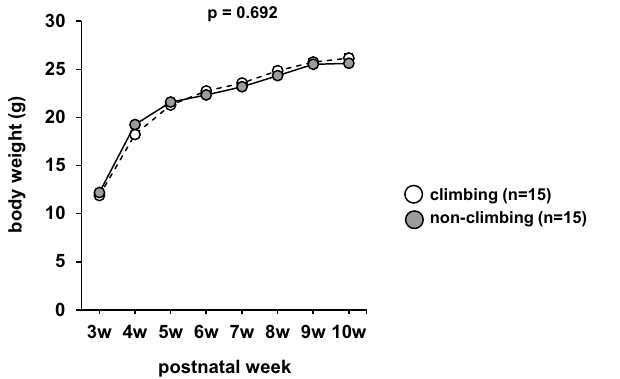
Figure 3. The effect of grid-climbing prevention on body weight. Body weight gain (in grams) following weaning (at 3 weeks of age), until 10 weeks of age. Data are presented as the mean ± standard errors. Statistical significance is represented by asterisks: * p < 0.05, + p < 0.1. P -values were calculated using the two-way repeated- measures analysis of variance. Climbing: n = 15; non-climbing: n = 15.